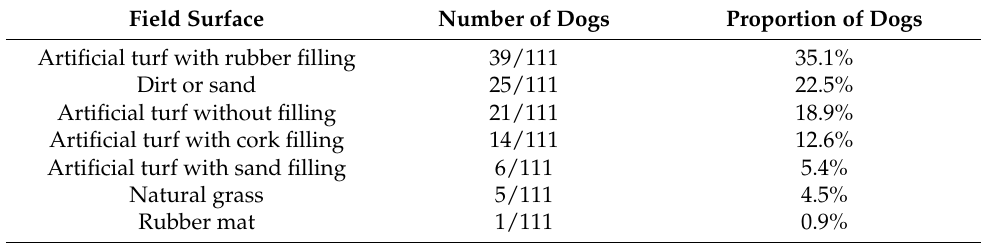
Table 4. Field surfaces at the time of injury ( n = 111).